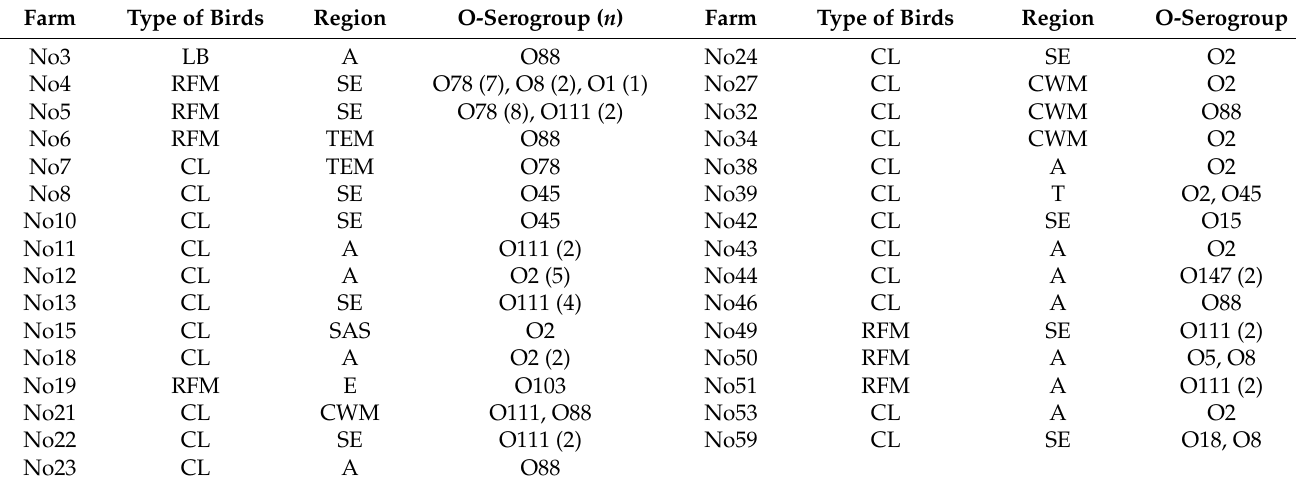
Table 4. Distribution of E. coli strains between farms with typeable serogroups.